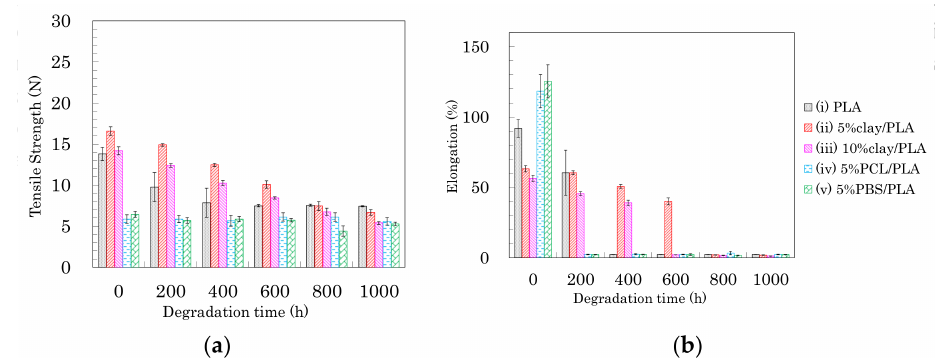
Figure 13. Tensile strength ( a ) and elongation ( b ) of 4 DR PLA fibers plotted versus degradation